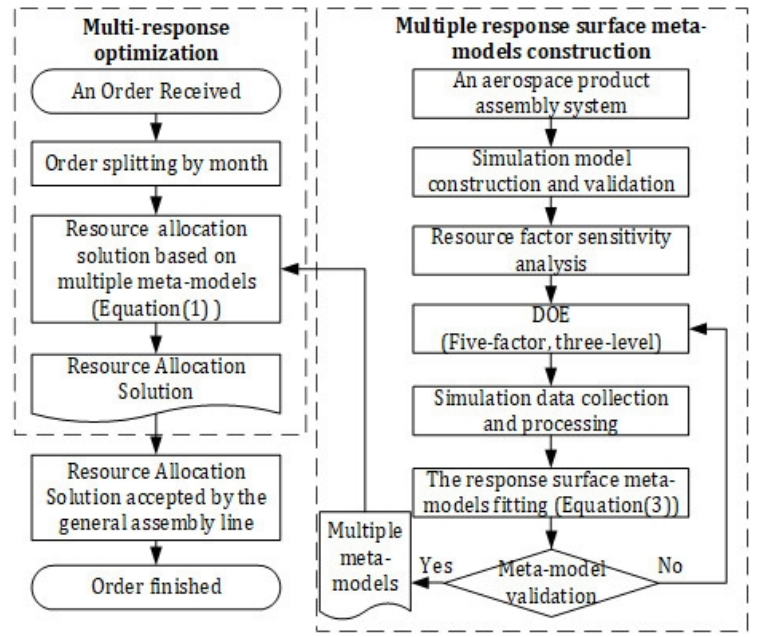
Figure 3. Metamodel-based, multi-response optimization